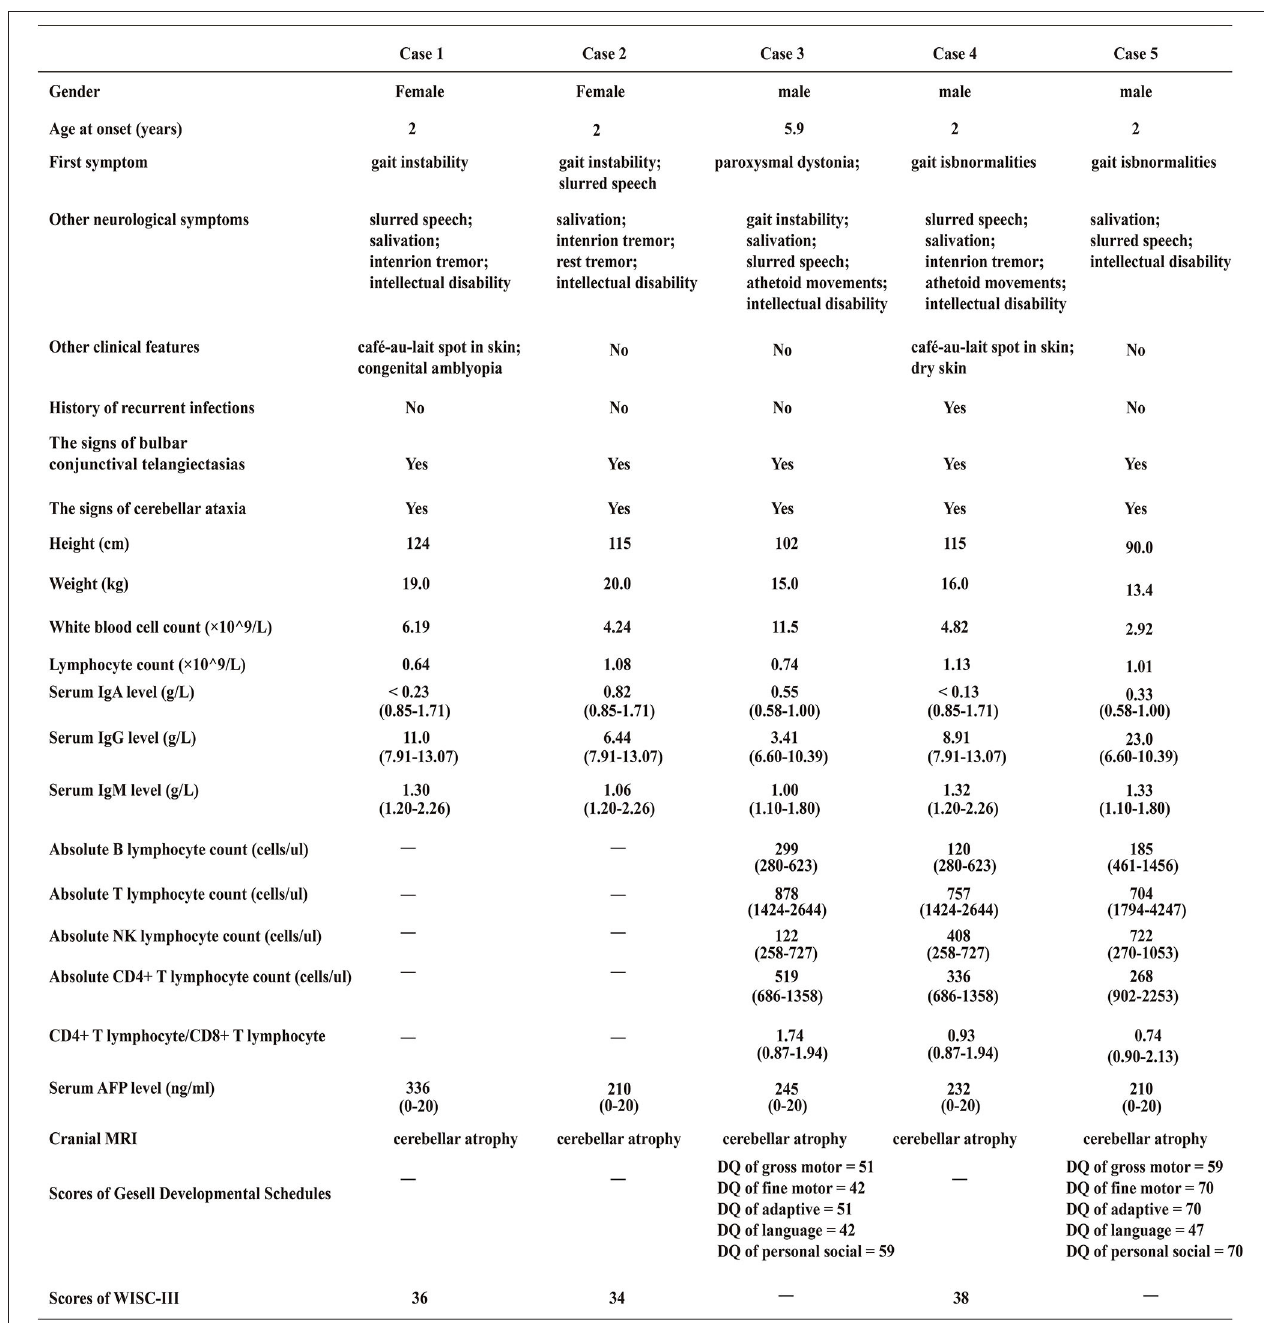
FIGURE 2 | Clinical characteristics of the five patients at the time of admission. “–”, Not done; “DQ”, Developmental Quotient; “WISC-III”, Wechsler Intelligence Scale for Children Third Edition; values in parentheses represent the range of reference values.